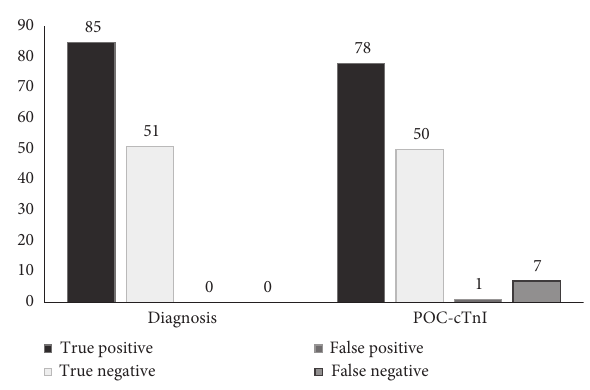
Figure 1: Test performance of 0-hour instant-view POC-cTnI qualitative assay for diagnosis of AMI according to the serial hs- cTnI